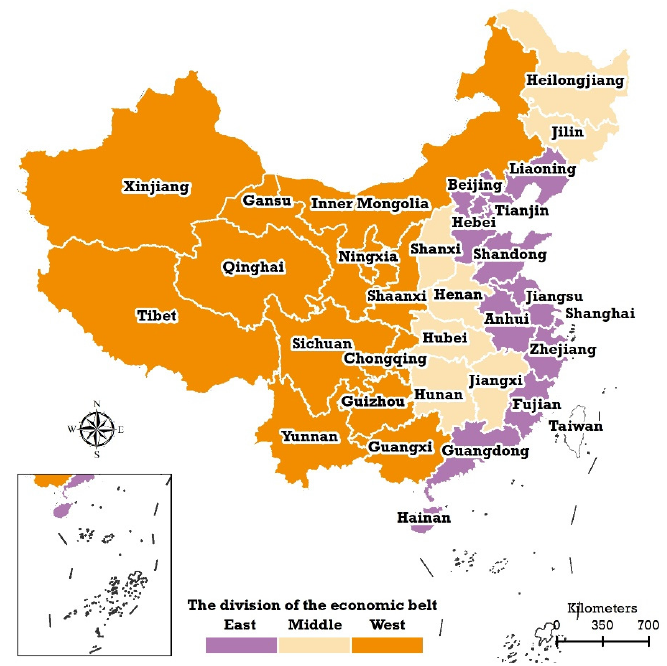
Figure 1. The geographical distributions of the three economical belts of the Chinese mainland: eastern, middle, and western China.